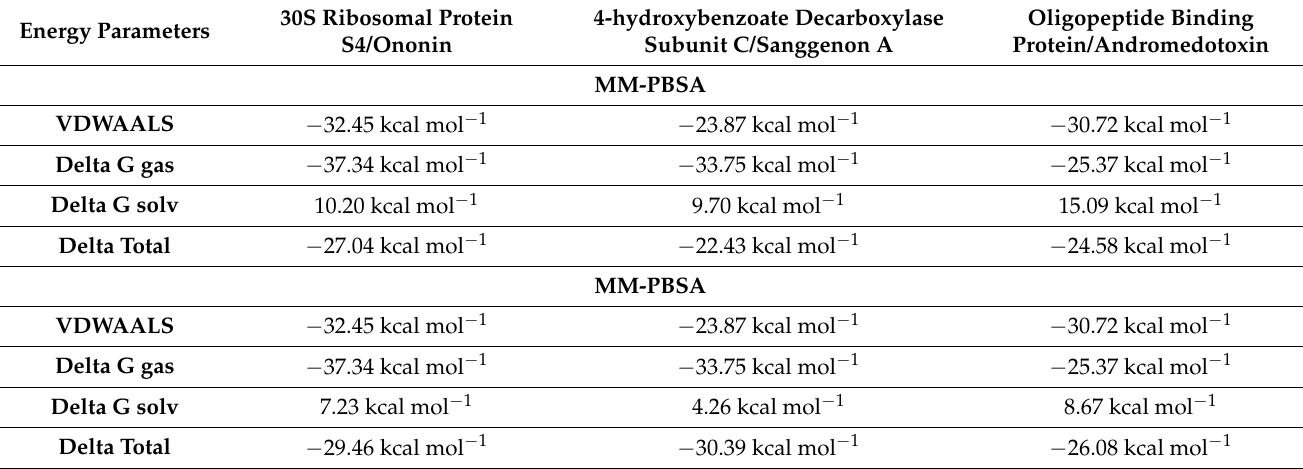
Table 6. Target proteins’ binding energies